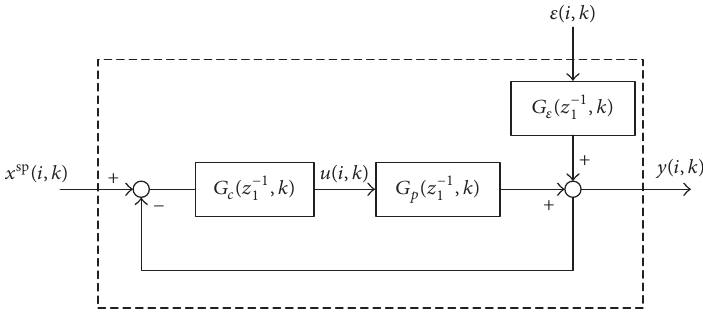
Figure 1: The feedback control structure of each batch 𝑘 .